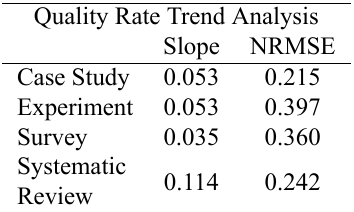
Table 4. Slope factor and NRMSE from trend analysis for